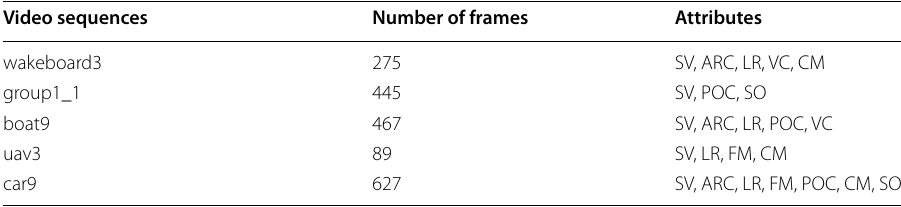
Table 3 Typical UAV sequences Video sequences